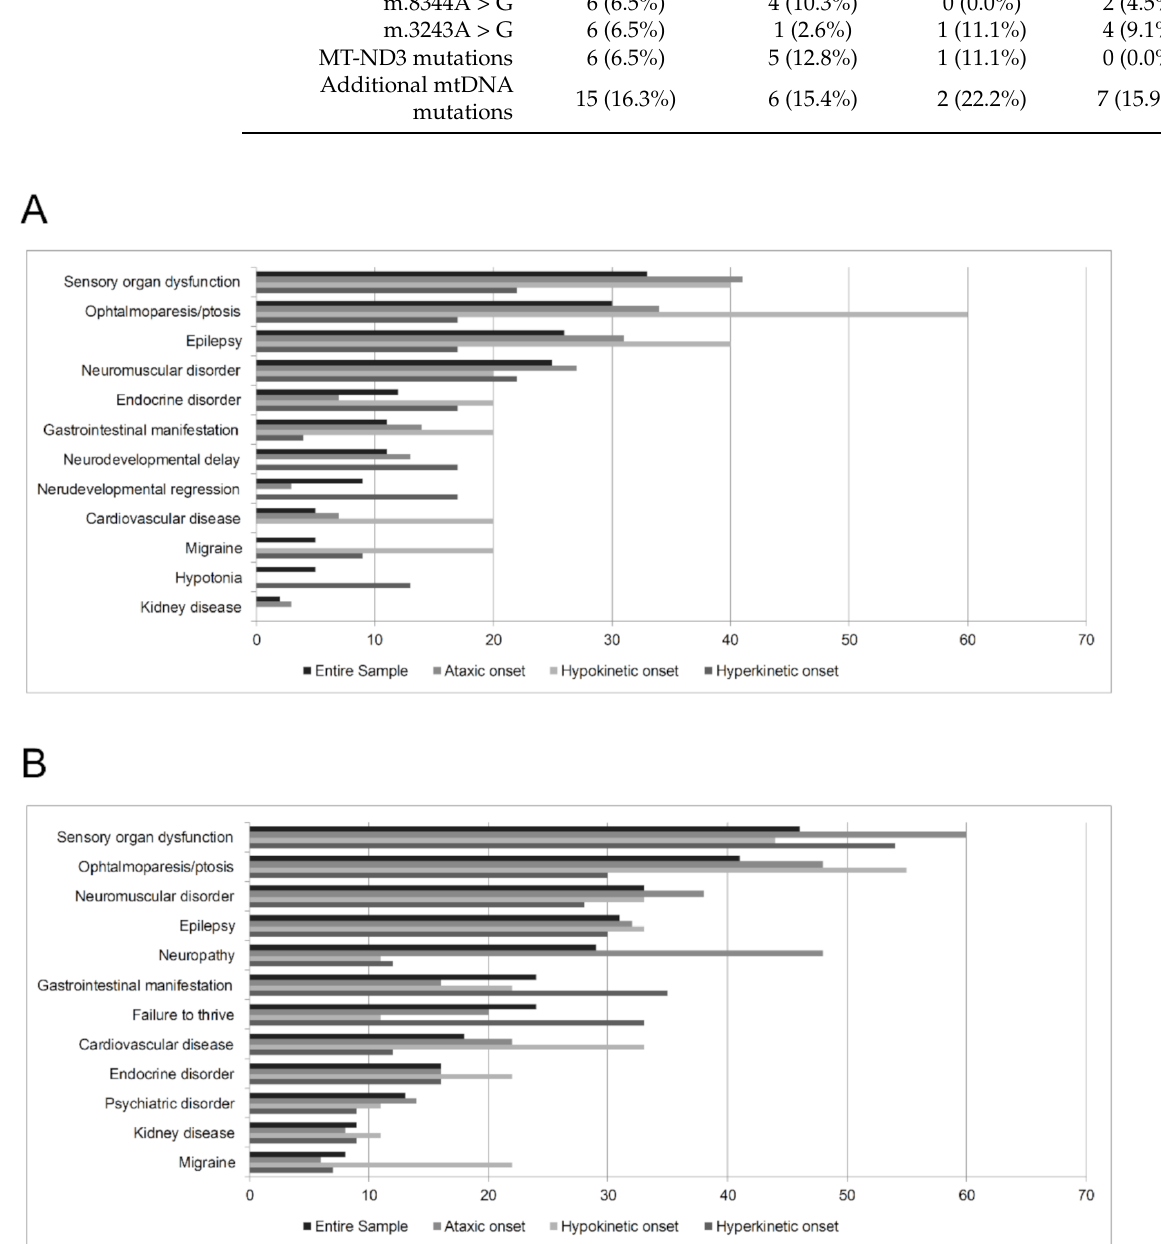
Figure 1. Symptoms preceding the movement disorder (in subjects in whom the movement disorder is not the first clinical feature; n = 56) ( A ) and comorbidities ( B ) in our cohort ( n = 102), described both for the entire group and for the different movement disorder type-onset subgroups (values reported as